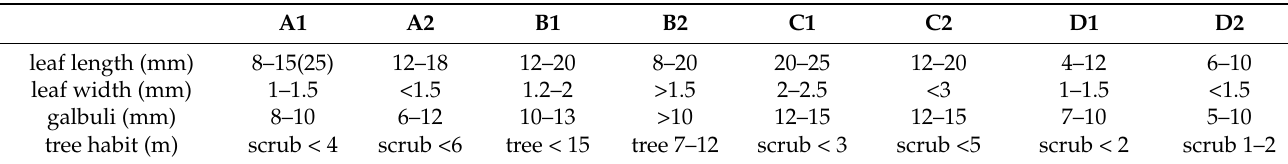
Table 4. Morphometric comparison in the taxa of Juniperus oxycedrus group. The samples analyzed correspond to Portugal for J. navicularis , Southern Spain for J. oxycedrus subsp. macrocarpa , South and Central Spain for J. oxycedrus subsp. oxycedrus , and subsp. badia (Supplementary material). Millimeters (mm) have been used as units of measurement for leaves and galbuli and meters for the height of the tree or shrub. A1, B1, C1, D1 bibliographic measures. A2, B2, C2, D2 own measurements. A. J. oxycedrus subsp. oxycedrus ; B. J. oxycedrus subsp. badia ; C. J. oxycedrus subsp. macrocarpa ; D. J. navicularis